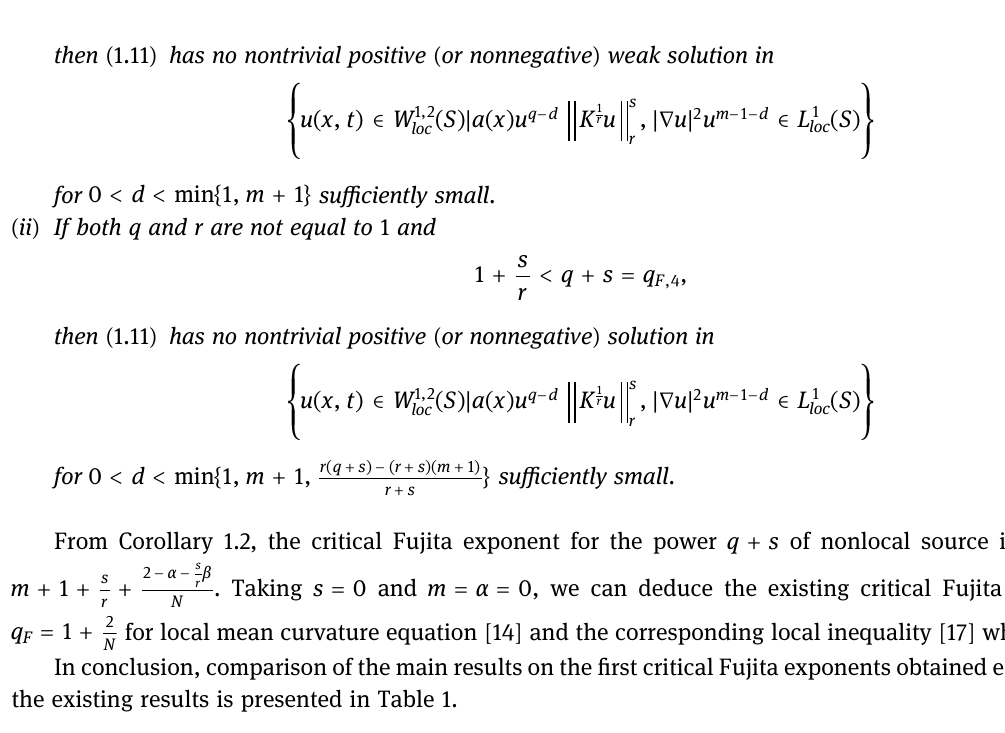
Table 1: First critical Fujita exponents Operators in ( 1.1